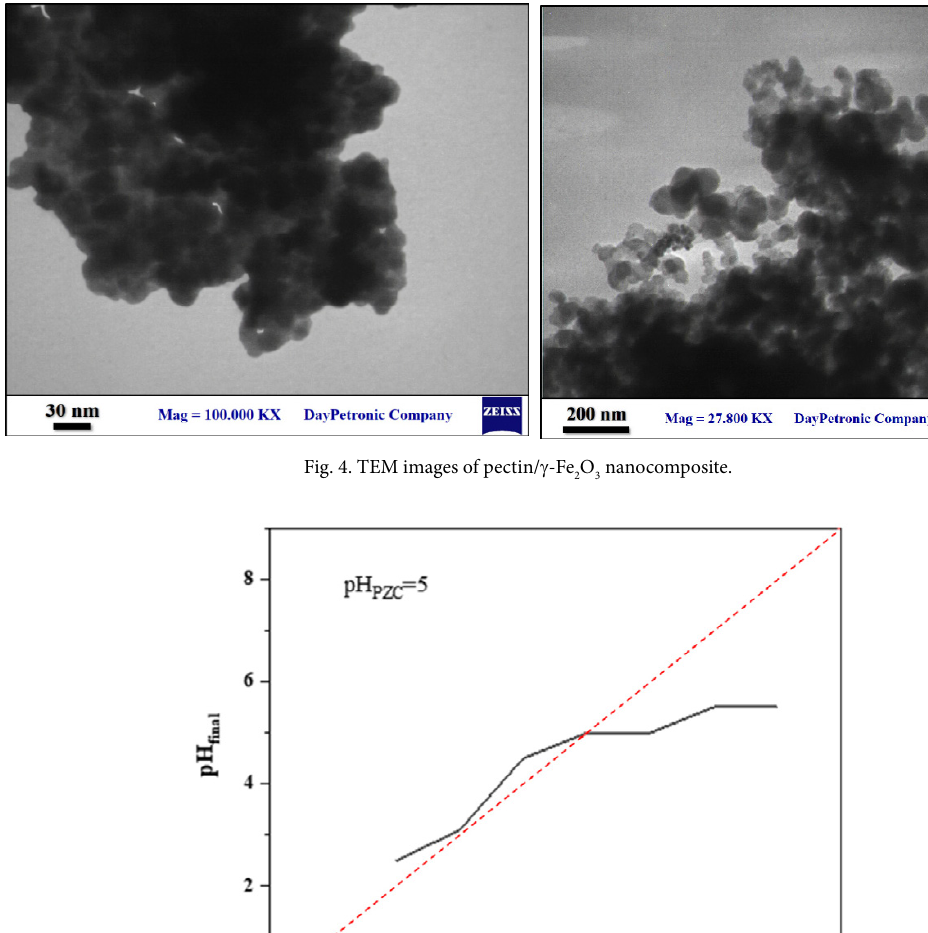
content of the pectin/ γ -Fe PZC